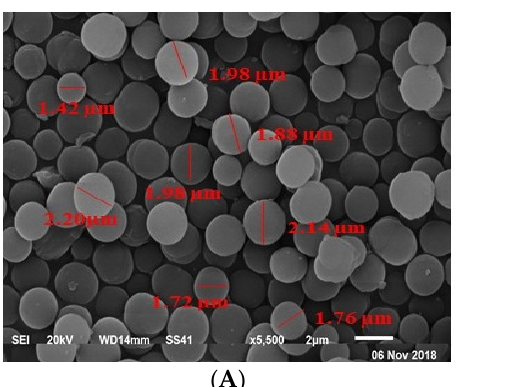
Figure 2. FT-IR spectra of fluvoxamine (FLX), FLV / MIP, washed molecular imprinting polymer (MIP) and non-imprinted polymer (NIP) beads.